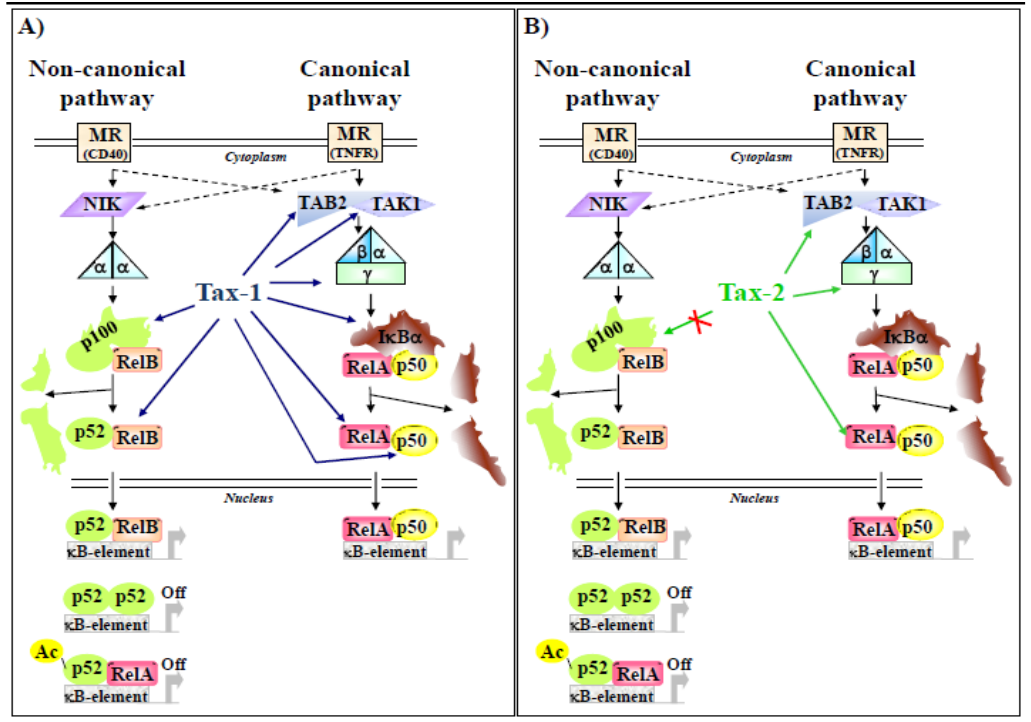
Figure 2. Tax-1 and Tax-2 interaction with NF-  B pathway. Schematic representation of the main steps in NF-  B pathaway. Non-canonical NF-  B activation involves the action of NF-  B inducing kinase (NIK) and IKKα subunit (α) and results in the C-terminal proteosomal degradation of p100 in p52 and in the nuclear translocation of NF-  B dimers containing p52. In the nucleus, the p52/RelB dimers induce gene expression, whereas p52 homodimers or acetylated p52/RelA heterodimers turn off gene transcription. Canonical NF-  B activation triggers a phosphorylation cascade involving kinases such as TAK1, adaptor proteins such as TAB2, and the IKK complex (here schematized as α, β and γ), and results in proteosomal degradation of cytoplasmic inhibitors (I  B) and in nuclear translocation of NF-  B dimers (mainly RelA/p50). In the nucleus, the RelA/p50 dimers induce gene expression for cytokines, enzymes and adhesion molecules. ( A ) Blue arrows identify Tax-1 interactions with NF-  B pathway factors; ( B ) Green arrows identify Tax-2 interactions or absence of interaction (red X) with NF-  B pathway